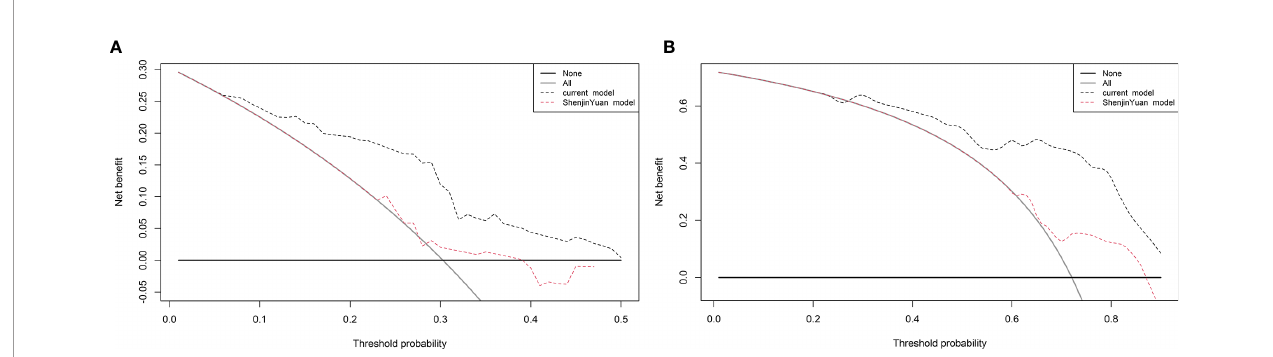
FIGURE 7 | Decision curve analysis for progression-free survival (PFS). The straight gray line represents the assumption that all patients will progress at (A) 6 and (B) 12 months, and the black horizontal line represents the assumption that no patients will progress at (A) 6 and (B)